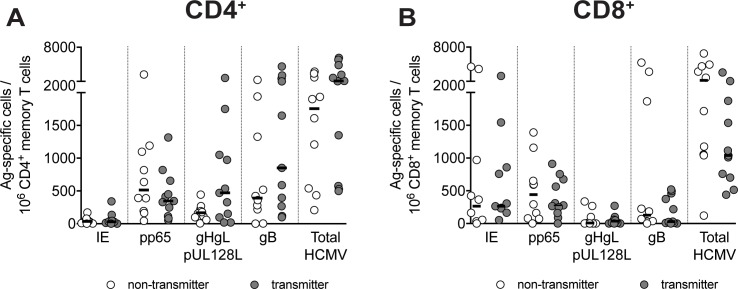
Pregnant women transmitting or non-transmitting HCMV to the fetus have comparable frequencies of specific T cells at early time points after infection.Frequencies of protein-specific (A) CD4+ and (B) CD8+ memory T cells in transmitting (n = 11) or non-transmitting mothers (n = 10) tested one month after HCMV infection onset are given. The total of HCMV-specific T cells is the sum of the single protein-specific T cells. Each symbol represents an individual and horizontal black lines indicate median values. No significant P value, as determined by Mann-Whitney U test, was found between T and NT women.